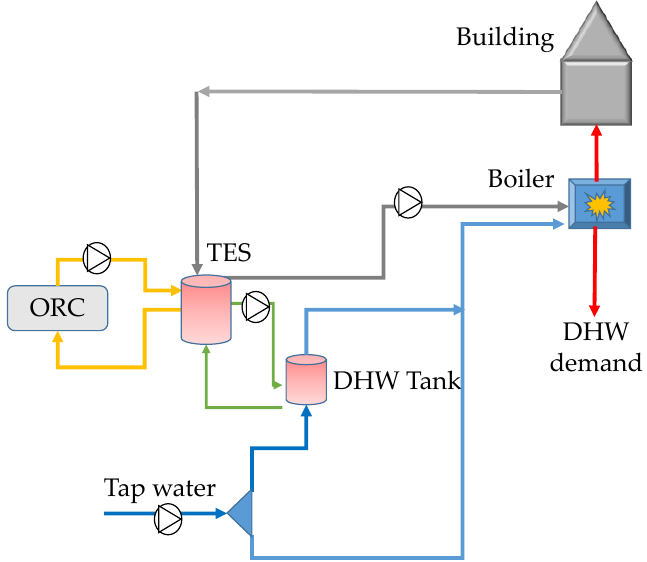
Figure 3. Space heating (SH) and domestic hot water (DHW) plant configuration.